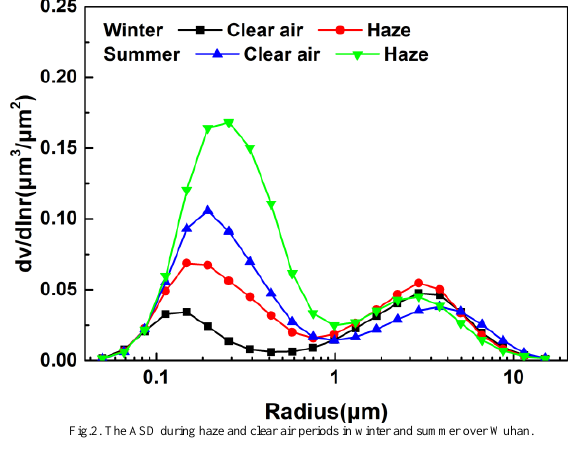
Fig.2. The ASD during haze and clear air periods in winter and summer over Wuhan.